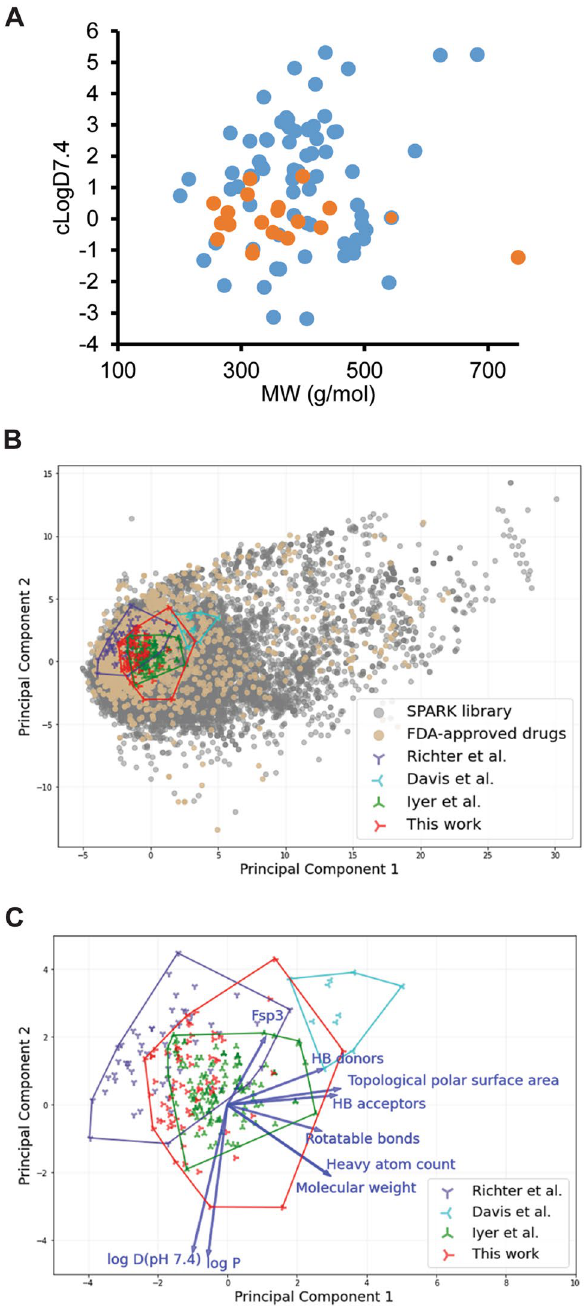
Figure 2. Properties of the library of 66 compounds analyzed in this study. ( A ) Size and lipophilicity of the analyzed compounds as represented by MW and cLogD 7.4 descriptors. Antibiotics are highlighted in orange. ( B ) Principal component analysis of diversity in the chemical space of molecules from SPARK library 35 , Richter et al. 16 , Davis et al. 15 , Iyer et al. 20 , FDA- approved drugs (extracted from 36 ) and this study. The outermost data points from the four studies are linked to show the relative size of the sampled space. ( C ) Zoom-in view of ( B ) and the loading vectors for this plot. Data points for the SPARK library and FDA-approved drugs are hidden for clarity. Molecular weight, hydrogen bond donors and acceptors, topological polar surface area, rotatable bounds and heavy atom count are the major contributing factors to PC1, whereas LogP, logD and the fraction of sp 3 hybridized carbon atoms (Fsp 3 ) are major contributors to